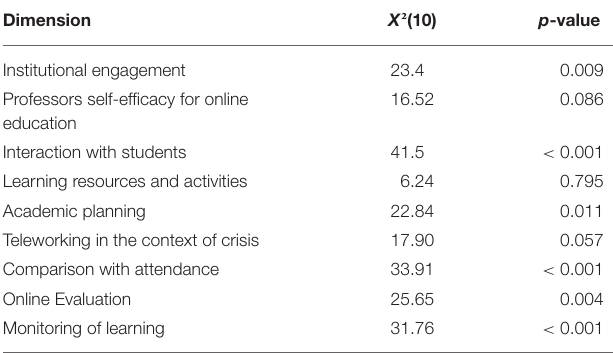
TABLE 6 | Effect of each expectation dimension on Model